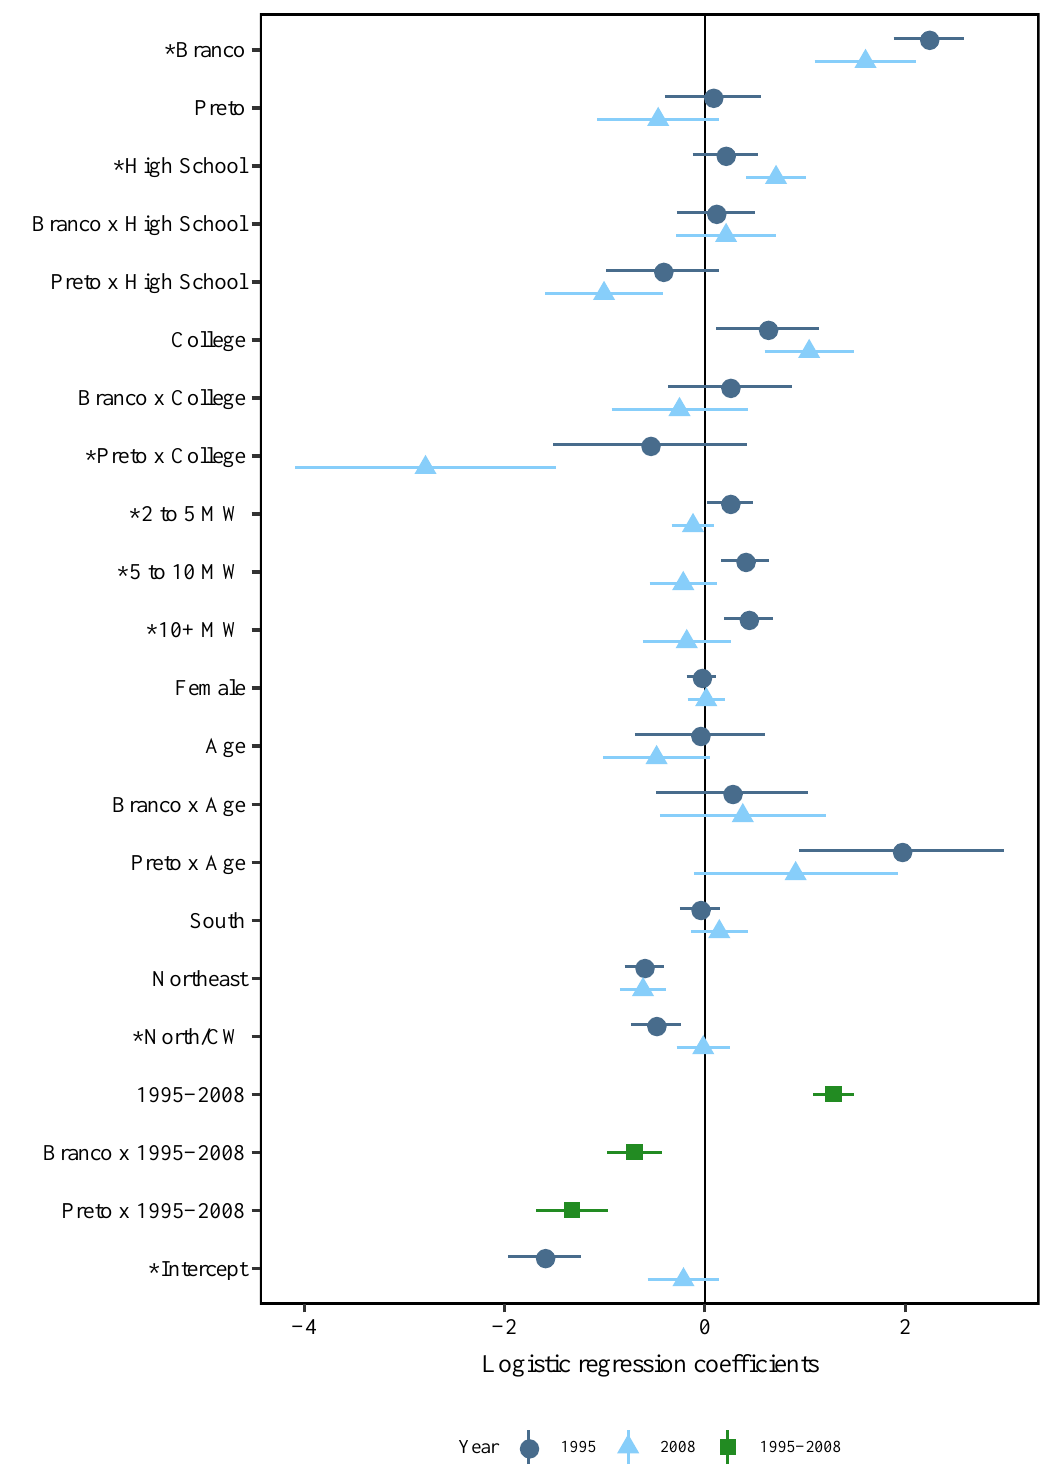
Figure 4: Logistic regression coefficients for the alignment of lay and government race, 1995 and 2008. sociological science | www.sociologicalscience.com